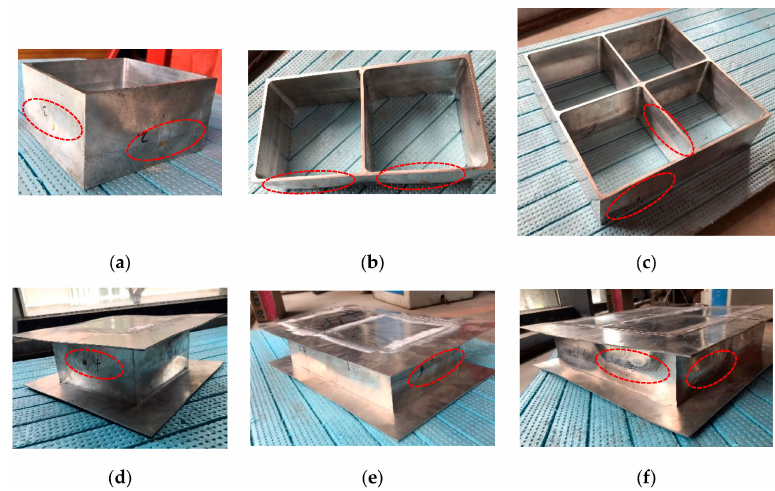
Figure 8. Failure modes of SHS honeycomb specimens: ( a ) Single SHS cell; ( b ) Double SHS cells; ( c ) Four SHS cells; ( d ) Single SHS cell with FSW facesheets; ( e ) Double SHS cells with FSW facesheets; ( f ) Four SHS cells with FSW facesheets.